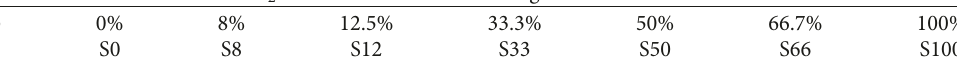
Table 1: Ar/N 2 ratio and numbered messages.